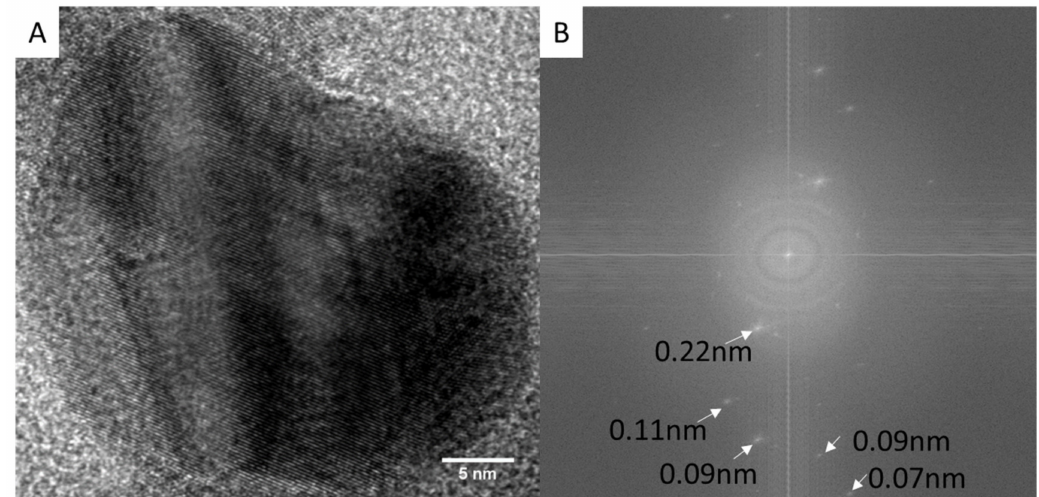
Figure 13. ( A ) HR-TEM image of nanoparticle, ( B ) FFT analysis of the image.